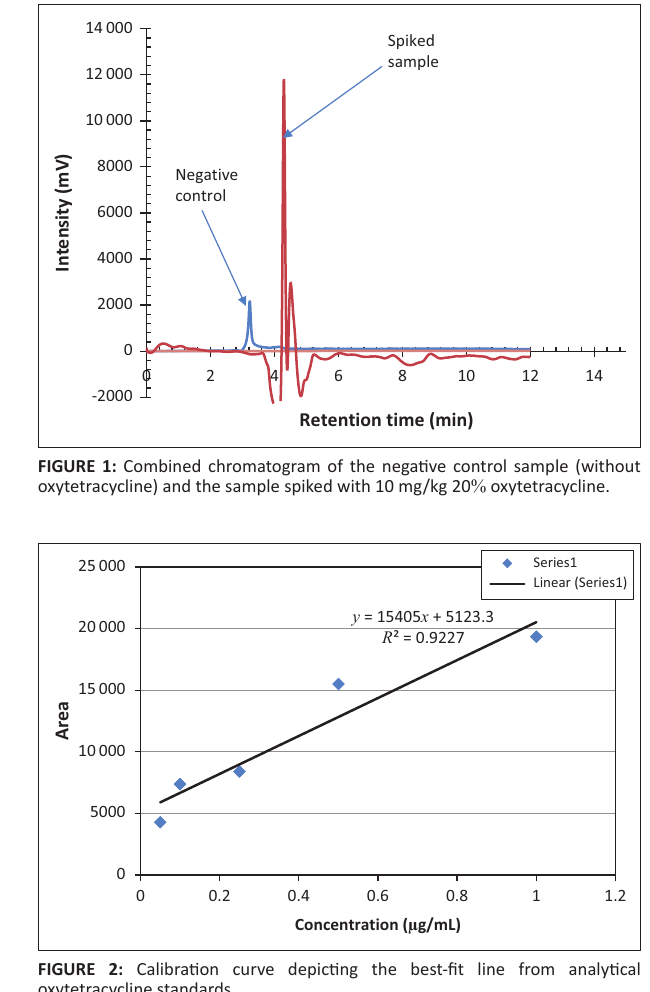
FIGURE 2: Calibration curve depicting the best-fit line from analytical oxytetracycline